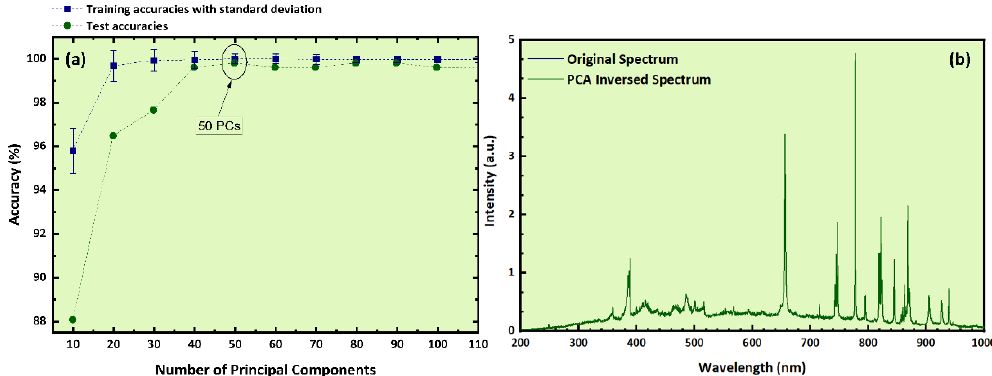
Figure 5. ( a ) Training and test accuracies as a function of the number of PCs, ( b ) experimental LIBS spectrum and PCA-inversed spectrum. Table 2. ( a ) Classification report and ( b ) confusion matrix for SVC external validation.